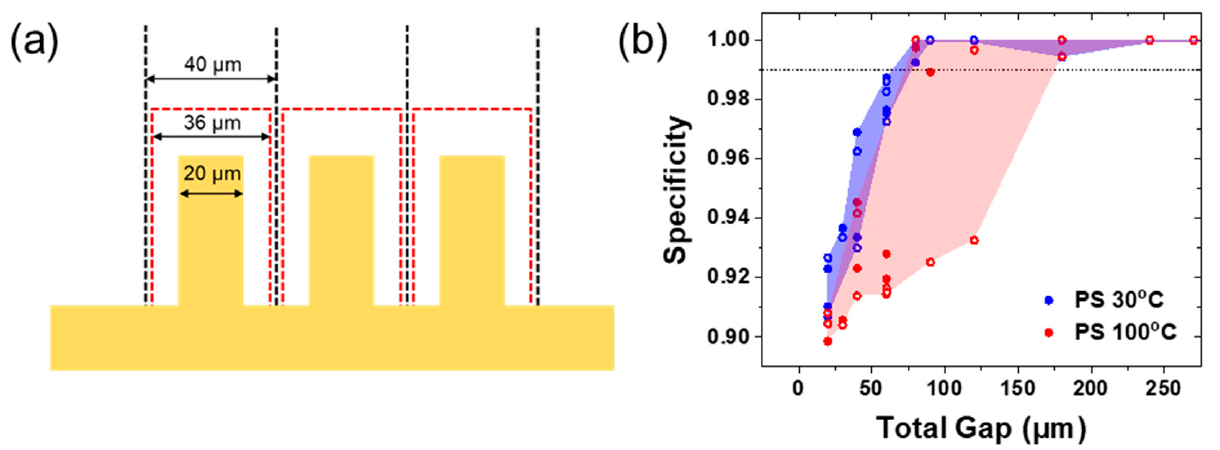
Figure 8. ( a ) Cross-section drawing of the expanded-feature-generated profile (red) relative to the actual feature (gold) and the total gap (black); ( b ) Specificity results for the expanded features.